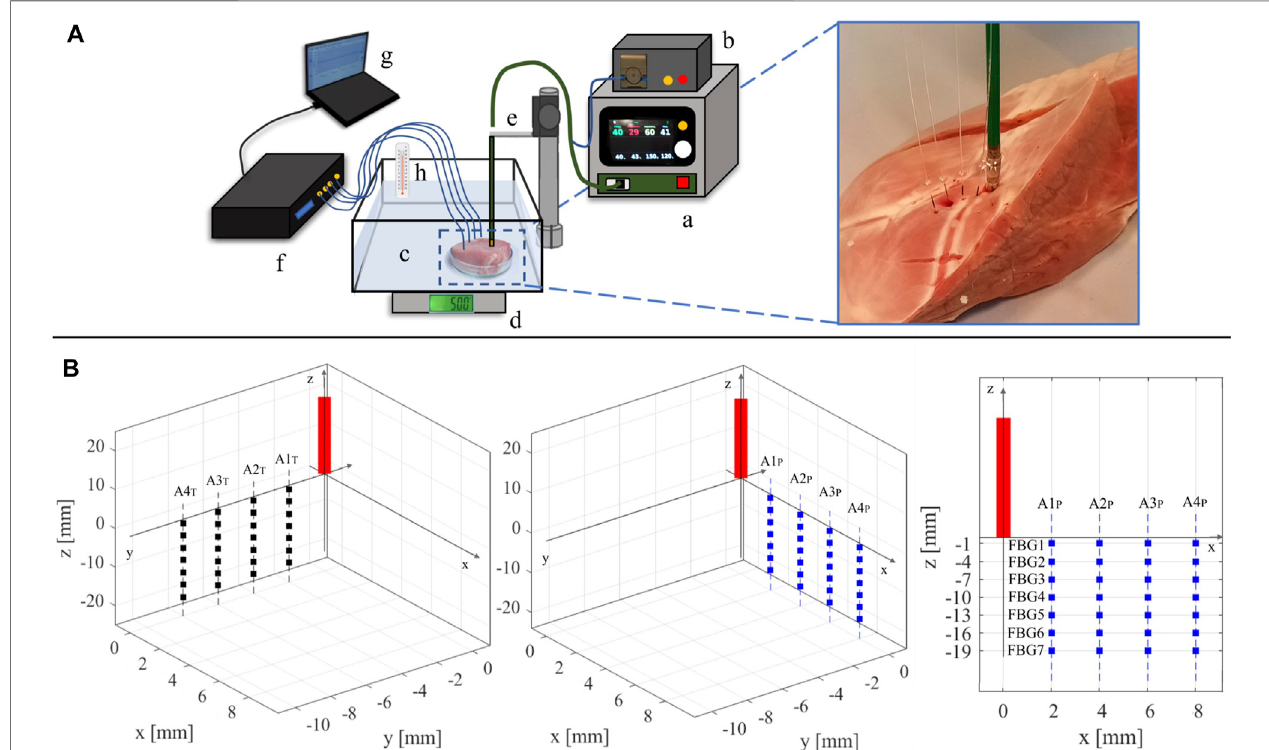
FIGURE1 | (A) Representation ofthe experimental setup: a) RF generator; b)cooling system; c) container with saline solution holding the myocardial specimen; d) digital scale; e) plexiglass RF antenna holder; f) spectrum analyzer connected to the four optical fi bers; g) personal computer; h) thermometer for temperature reference. On the right, a zoom-in on the tissue specimen displaying the placement of the RF antenna and the four fi ber optics is reported. (B) Schematic of the RF antenna and FBGs placement within the specimen. The FBGs positioning into the y-z plane (left image) and in the x-z plane (central image) with respect to the RF antenna (red rectangle)isreported.Ontheright,thearrangementoftheFBGsinoneofthetwoplanes(x – z)isdepictedasanexample.TheRFantennatipisconsideredastheoriginof the plane.